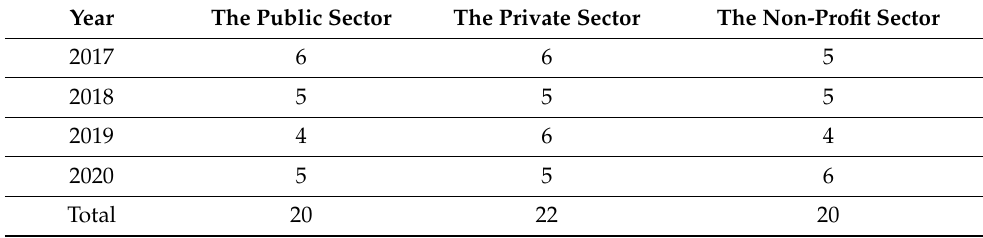
Table 2. An overview of the number of interviews with representatives of